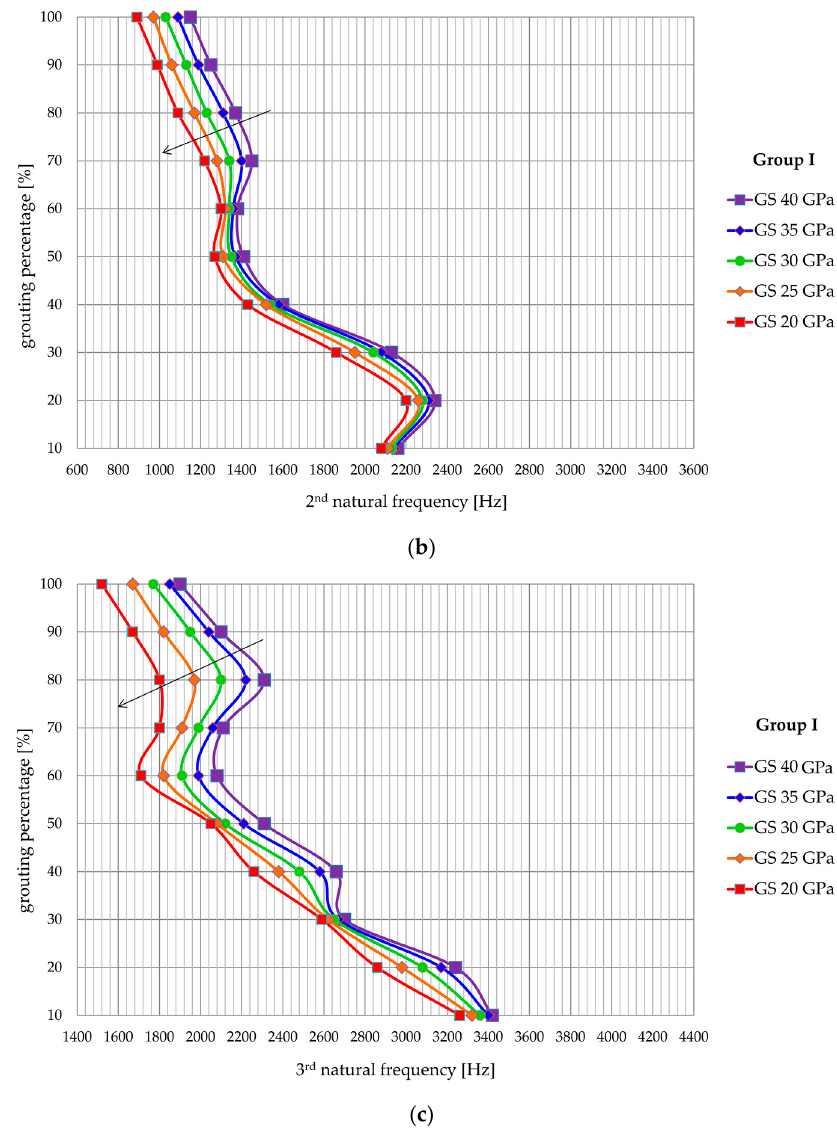
Figure 14. Influence of grout stiffness on ( a ) first, ( b ) second, and ( c ) third natural frequency of Group I I models.